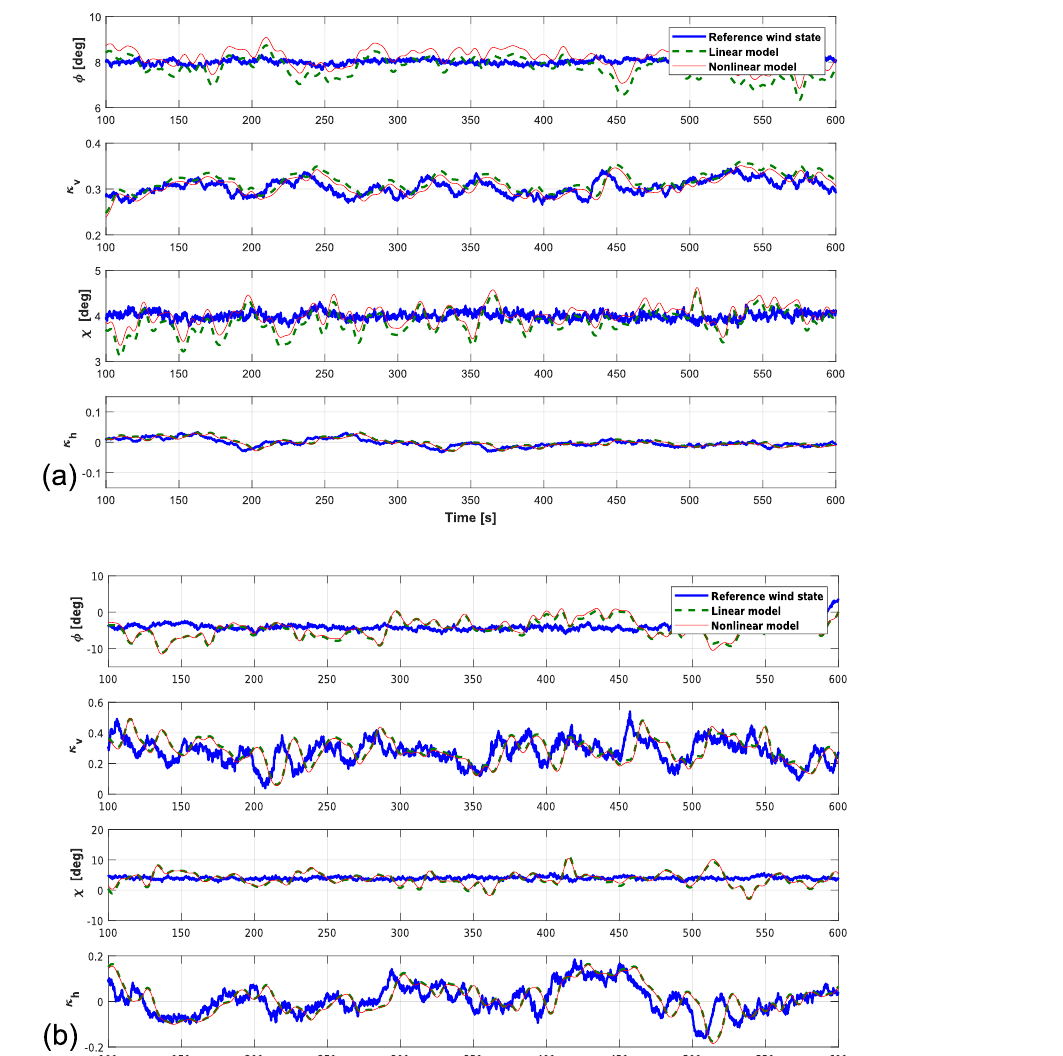
Figure 12. Wind state observations in turbulent wind conditions at 7ms − 1 for a TI equal to 2 (a) and 12% (b) . Solid thick blue lines: reference wind parameters; dashed thick green lines: observations by the linear model; solid thin red lines: observations by the nonlinear